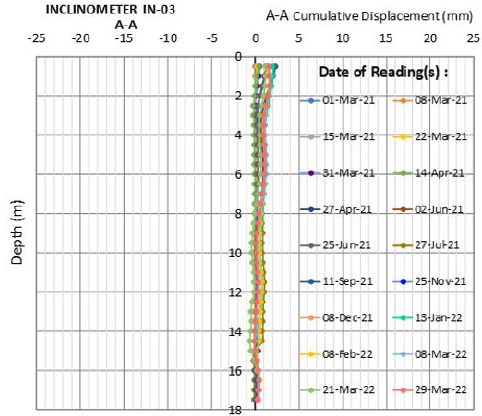
Figure 15. Inclinometer reading IN-03.